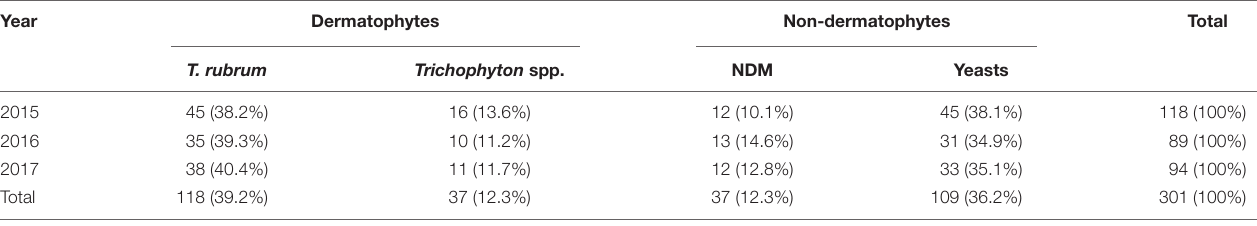
TABLE 2 | Distribution of 301 fungal isolates from cases of onychomycosis confirmed by different cultures in patients seen in the Teaching and Research Laboratory of Clinical Analysis at the Universidade Estadual de Maringá from January 2015 through December 2017. Year